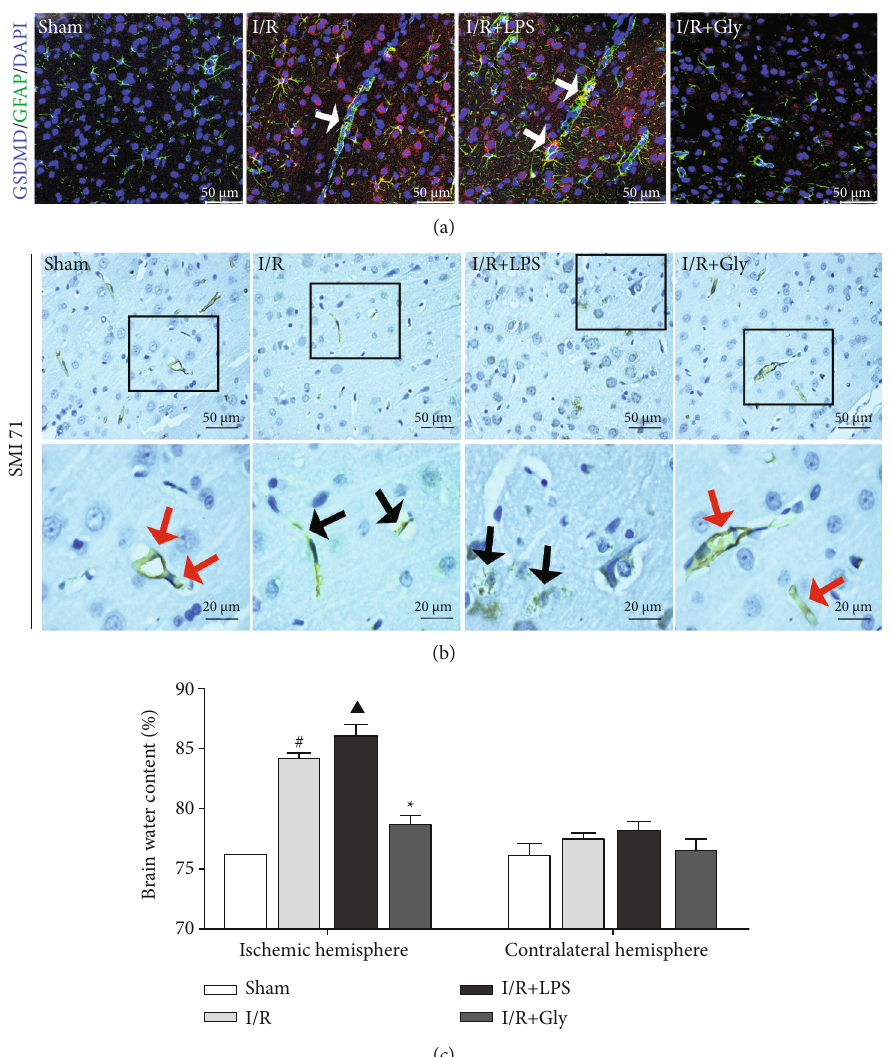
Figure 4: In fl uences of pyroptosis on BBB integrity at 24 h after reperfusion. (a) Representative pictures of double immuno fl uorescence stainings of GSDMD (red) colocalized with GFAP (green); white arrows represent astrocytic pyroptosis, scale bars, 50 μ m. (b) Representative pictures of immunohistochemical staining of SMI 71. Red arrows show smooth and intact capillaries which represent normal BBB integrity, and black arrows represent the damage of BBB integrity with unsmoothed, shriveled, or ruptured capillaries, scale bars, 50/20 μ m. (c) Brain water content analysis of ischemic hemisphere, n = 4 . Data are presented as mean ± SD . # P < 0 : 05 , I/R group versus sham group; ▲ P < 0 : 05 , I/R +LPS group versus I/R group; ∗ P < 0 : 05 , I/R +Gly group versus I/R